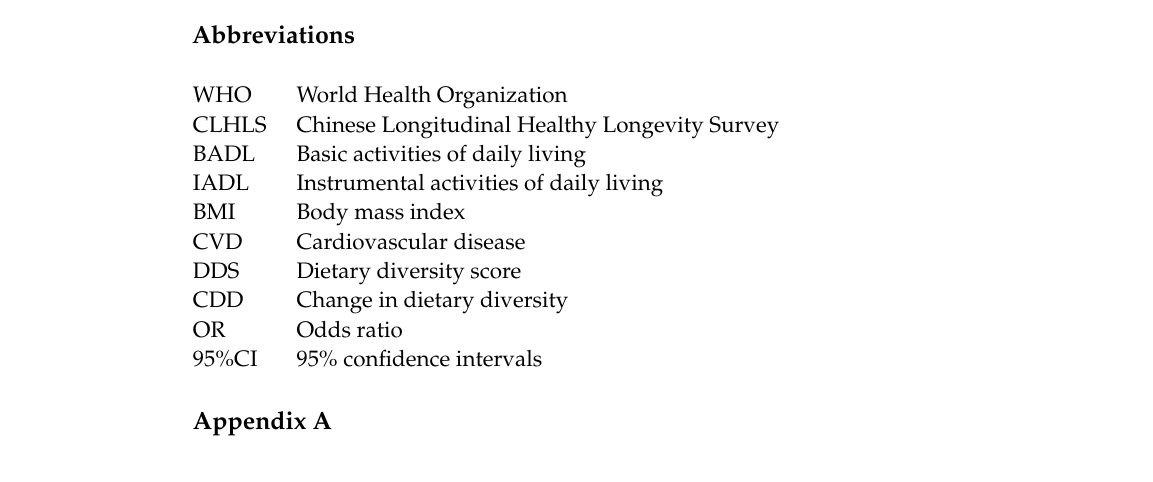
Table A1. Scoring criteria for dietary diversity.